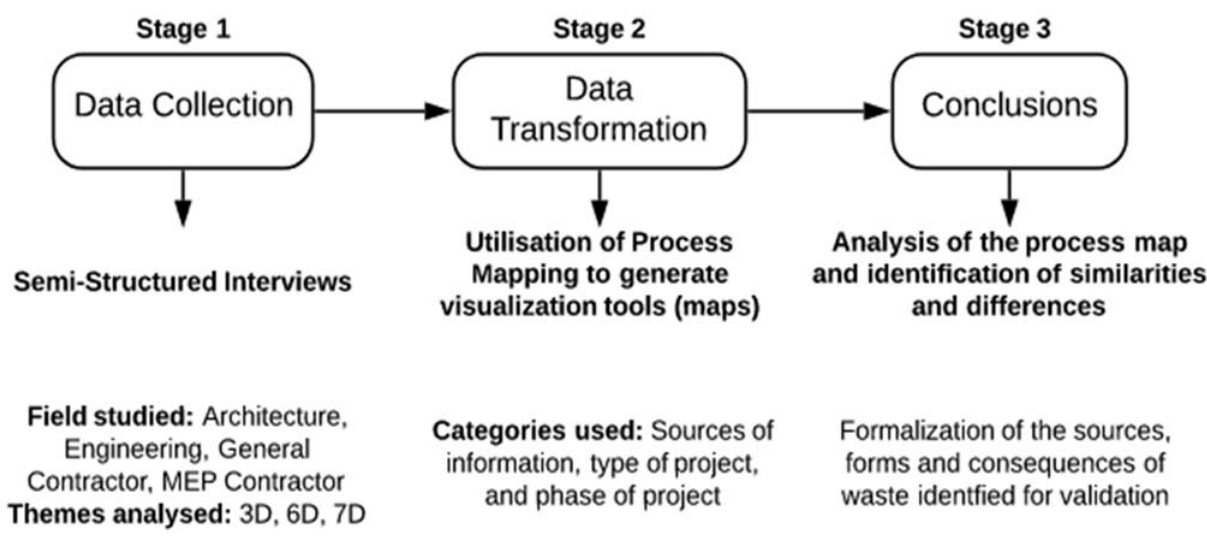
Figure 1. Stages of qualitative data analysis.